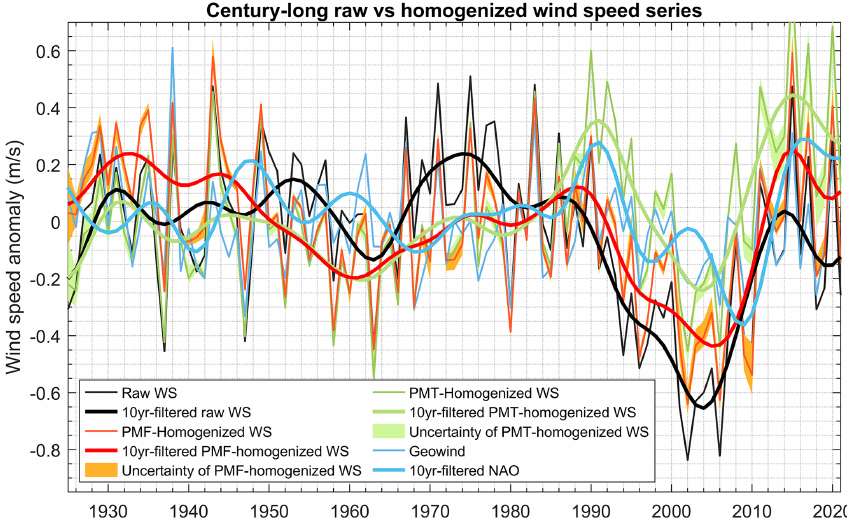
Figure 6. The averaged wind speed anomaly series at the 13 stations from raw and homogenized data (in black, red or green lines). The uncertainty of the homogenized data with CERA-20C 10-member ensembles as the reference series is shown in brown or green shading. The 10-year low-pass-filtered series of raw data, homogenized data, and scaled North Atlantic Oscillation (NAO) are shown by thick lines. Geowind series is also shown to depict the signal of internal climate variability (in blue line). For comparison, the PMF and PMT tests were applied to detect change points during the